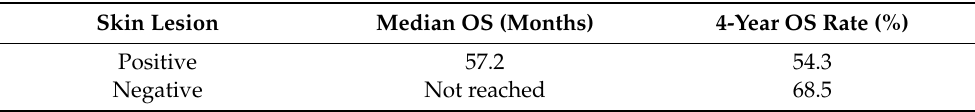
Table 6. Survival of the patients with smoldering ATL positive or negative for skin lesions.